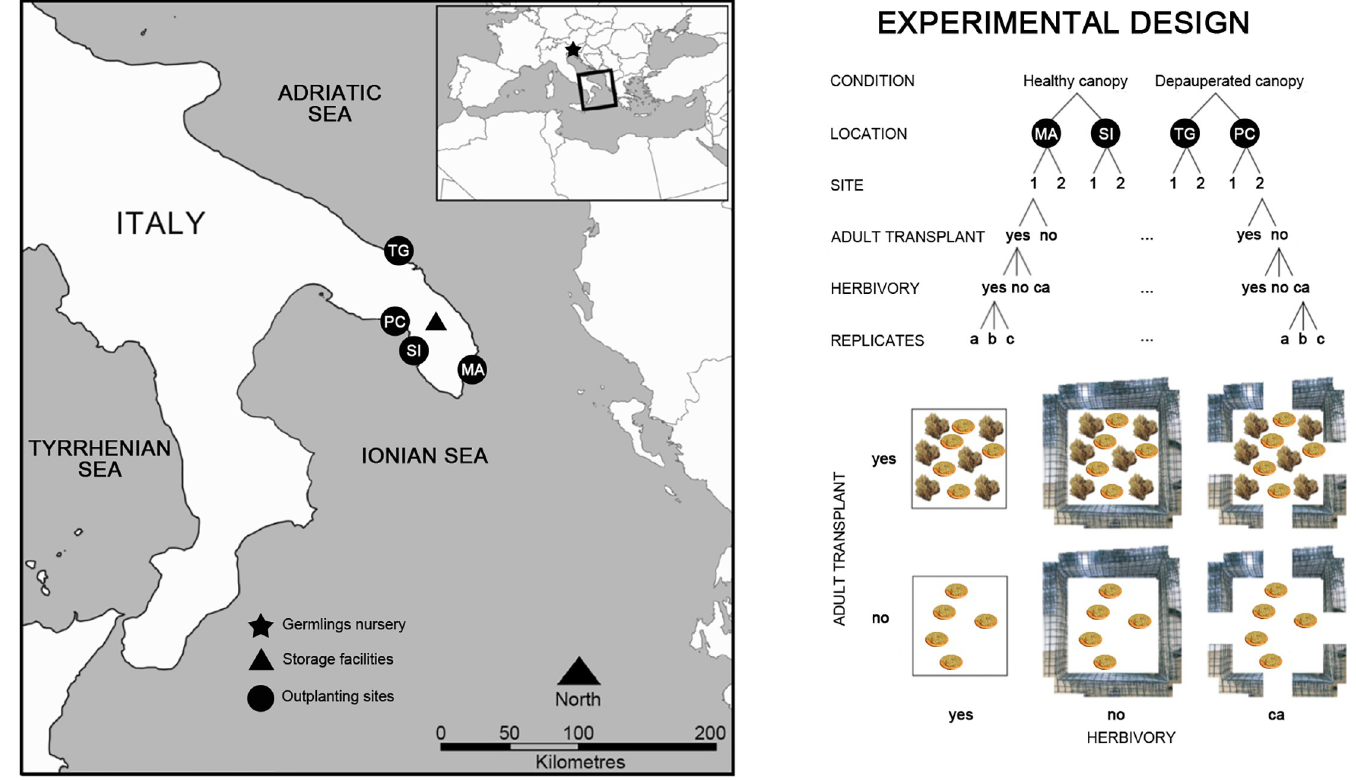
Fig 1. Experimental design and locations. On the left side, map of nursery (University of Trieste), storage (University of Salento), and experimental locations. MA = Marittima (Donor); SI = Sant’Isidoro (Donor); TG = Torre Guaceto (Restoration); PC = Porto Cesareo (Restoration). On the right side, the experimental design and treatments are schematically represented. CA = control of artifact. Maps were created using ArcGIS1 10.1 software by ESRI (Environmental Systems Resource Institute, www.esri.com).